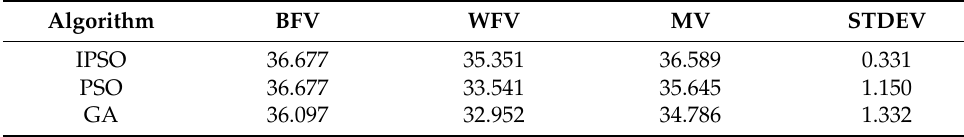
Table 5. Experimental results of each algorithm.